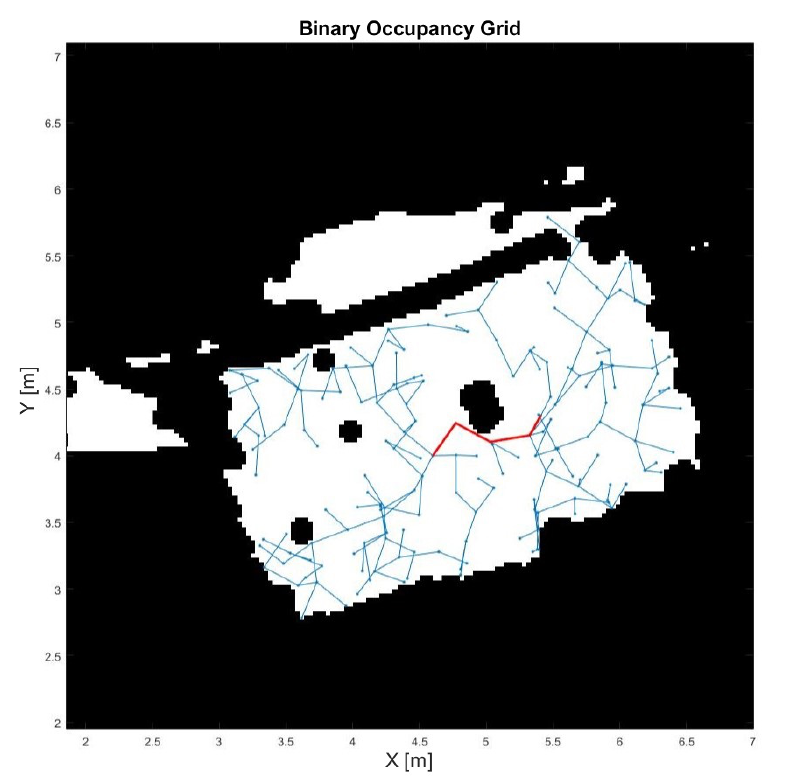
Figure 2. The generated tree and the found path from the start point to the end